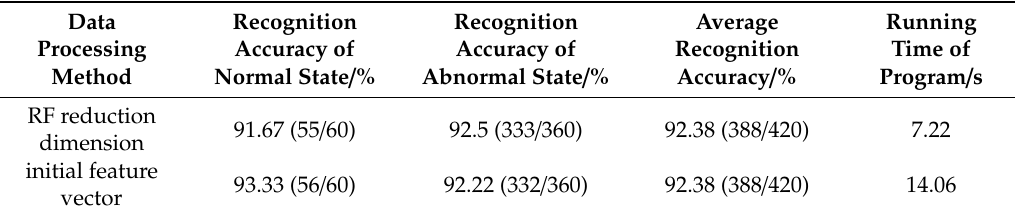
Table 6. The comparison result of the classification e ff